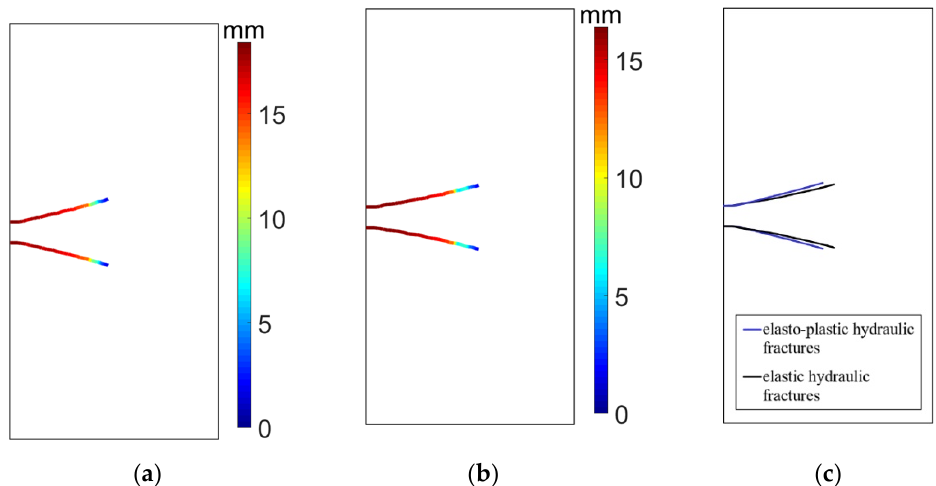
Figure 16. Comparison of fracture width and trajectories. ( a ) Elasto-plastic fracture width; ( b ) elastic fracture width; and ( c ) fracture trajectories.